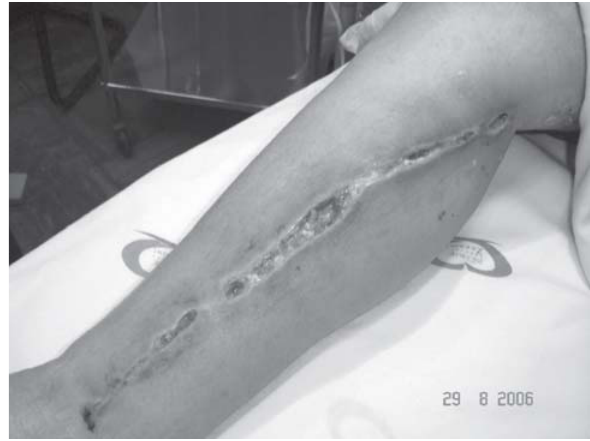
Fig. 1 - Deiscência da safenectomia: antes da 1ª aplicação do LBI